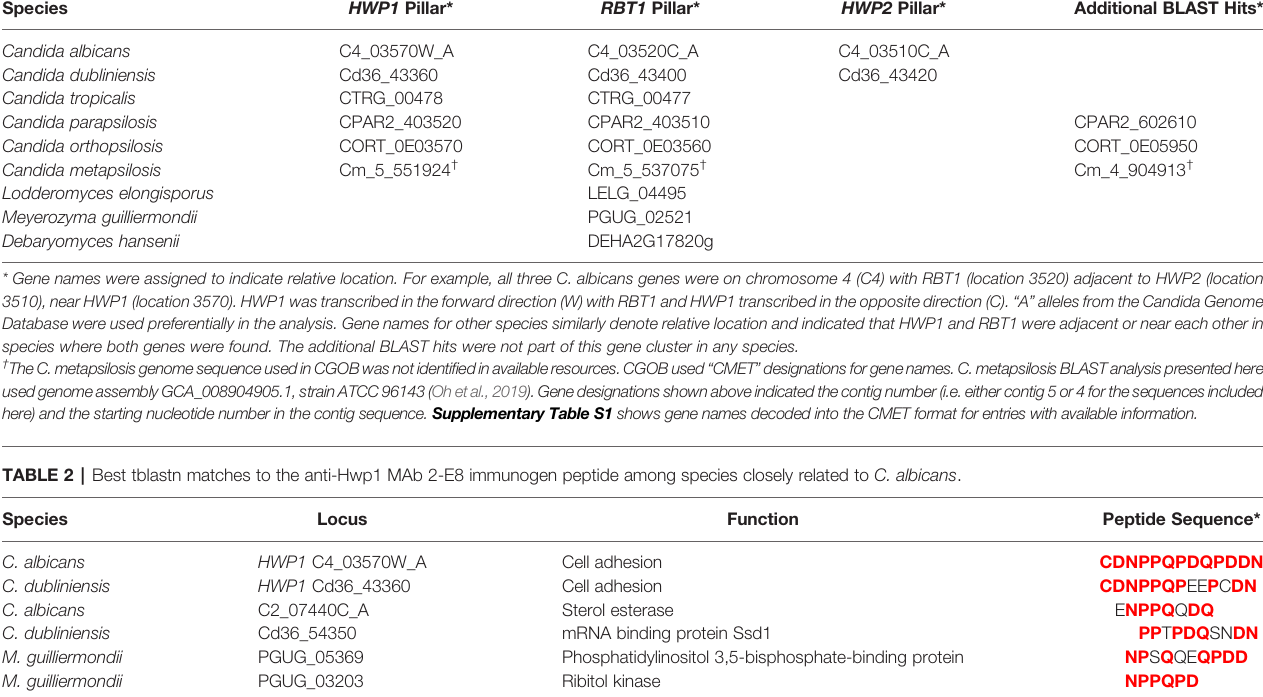
TABLE 1 | HWP1 , RBT1 , and HWP2 orthologs in Candida albicans and closely related species as displayed in the Candida Gene Order Browser (CGOB) and detected using BLAST.